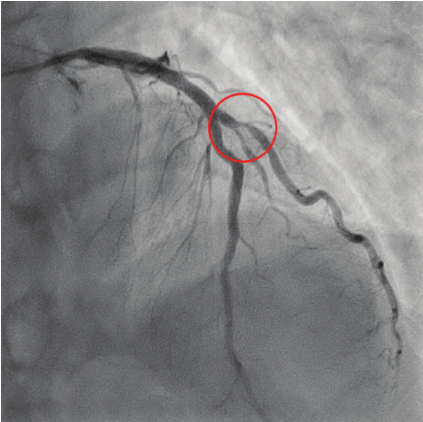
Figure 3: Repeat intravascular ultrasound imaging revealed improved apposition of the stent strut.